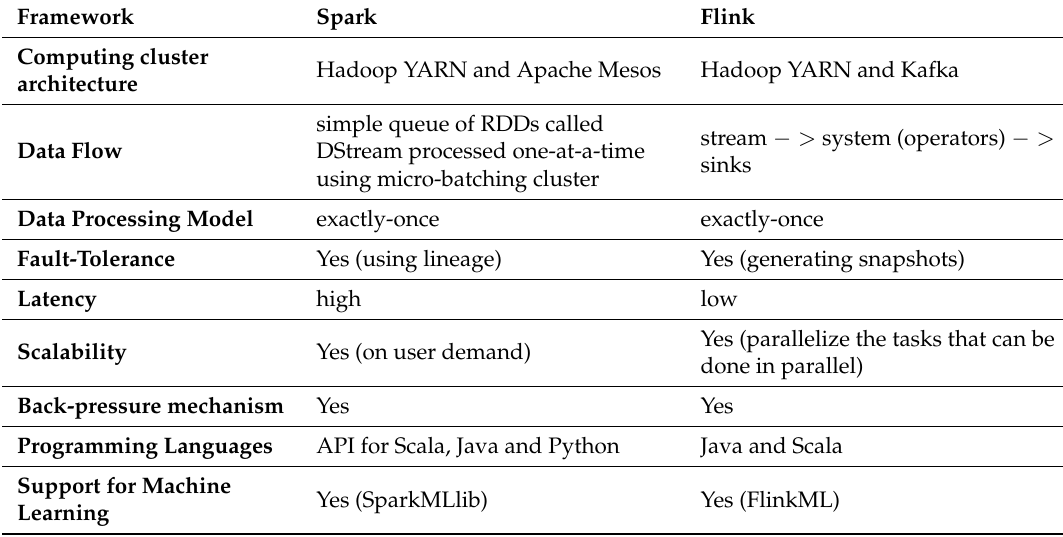
Table 3. Comparison of hybrid processing